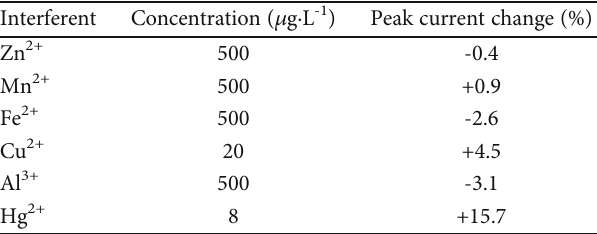
Table 2: Interferences of some metallic ions on the SWASV peak currents of 5.0 μ g · L -1 Pb 2+ . Interferent